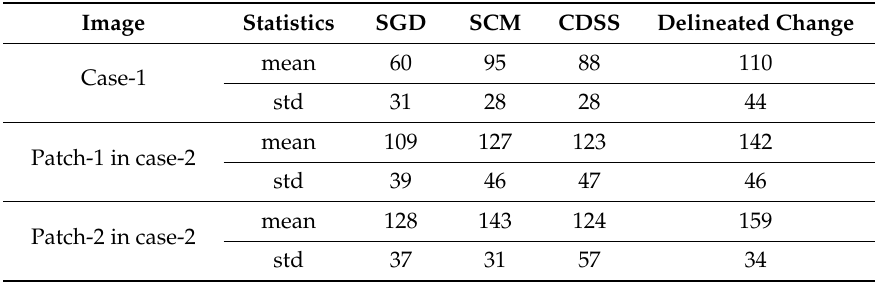
Figure 9. The images of HECred_S and HECred_V for case-1. Table 4. The statistics of pixel values of the specific areas in the image of HECred_S of two cases. The specific areas were the omission areas of SGD, SCM, CDSS and the delineated changes